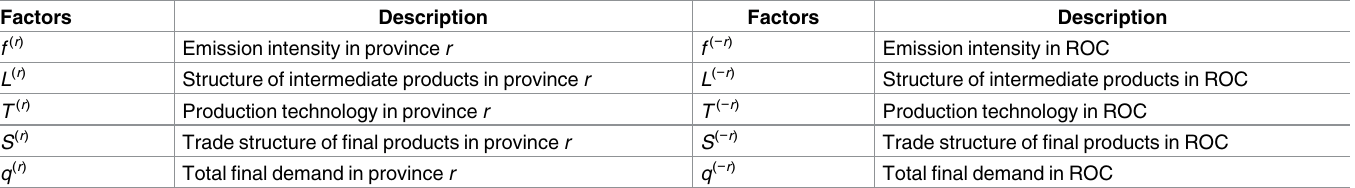
Table 1. Description of structural decomposition components of